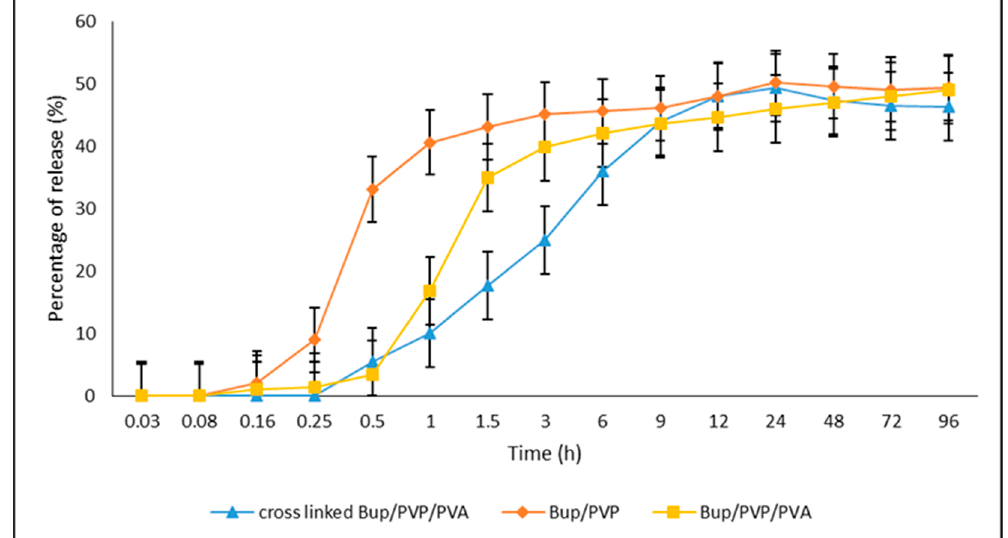
Figure 11. The buprenorphine release profile of electrospun drug-loaded nanofiber mats (900 mL phosphate buffered saline, 100 rpm, 37 °C).